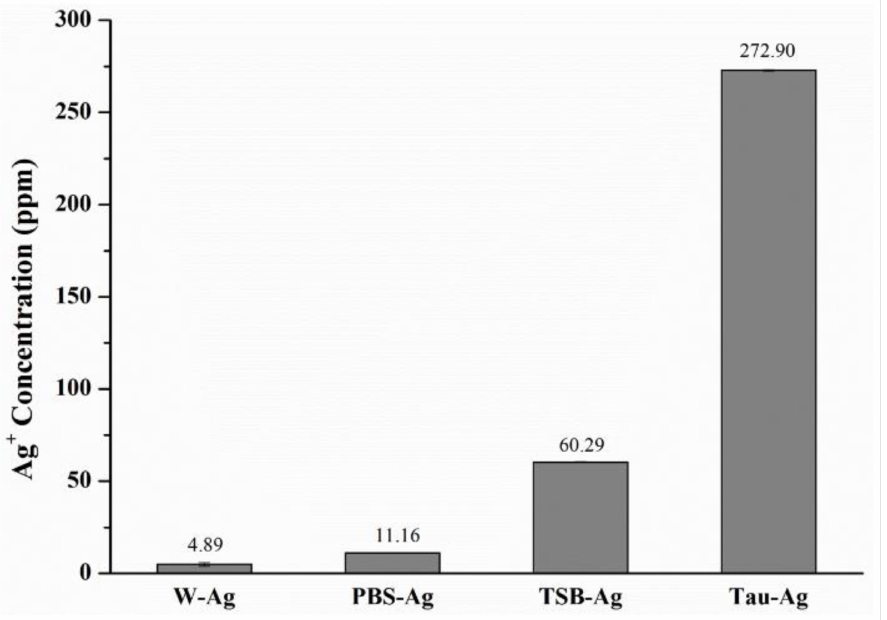
Figure 1. ICP-MS results of the silver content in W-Ag, PBS-Ag, TSB-Ag, and Tau-Ag. To better investigate the ion state of silver species in four different matrixes, the high-resolution XPS spectra of W-Ag, Tau-Ag, PBS-Ag, and TSB-Ag are demonstrated in Figure 2. The silver states were described as Ag(1) and Ag(0) for the ionic and metallic silver, respectively. The XPS spectra for Ag 3d 5/2 and Ag 3d 3/2 in W-Ag were revealed as Ag(0) (367.7 and 373.7 eV) and Ag(1) (366.9 and 372.9 eV) in Figure 2a; the Ag 3d 5/2 and Ag 3d 3/2 spectra for PBS-Ag were found to be Ag(0) (367.4 and 373.4 eV) and Ag(1) (367.2 and 373.2 eV) in Figure 2b; the Ag 3d 5/2 and Ag 3d 3/2 spectra for TSB-Ag were found to be Ag(0) (367.8 eV) and Ag(1) (366.3 eV) in Figure 2c; and the Tau-Ag spectrum was assigned to Ag(0) (369.3 and 375.3 eV) and Ag(1) (367.9 and 373.9 eV) in Figure 2d. Moreover, the ratio of Ag(1)/Ag(0) was found to be 0.07 in W-Ag, 0.91 in PBS-Ag, 1.26 in TSB-Ag, and 6.91 in Tau-Ag, illustrating a higher proportion of Ag(1) in Tau-Ag than in the